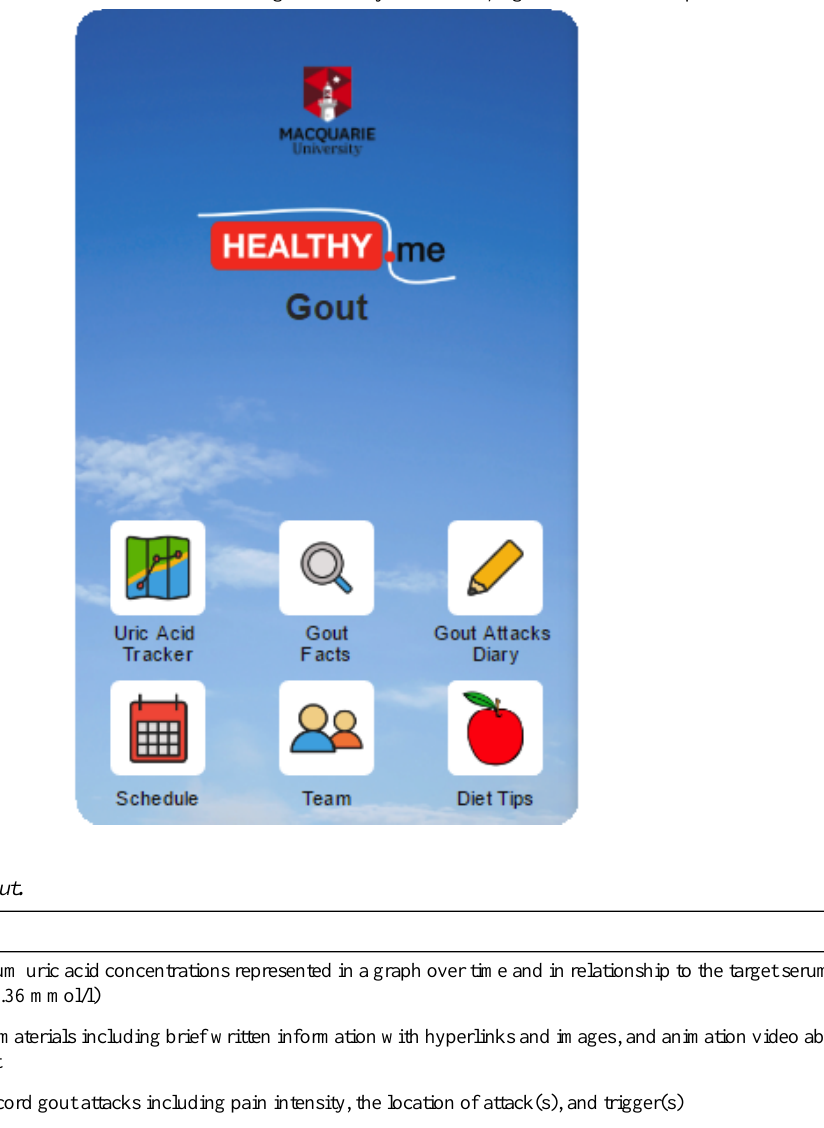
Figure 4. Screenshot of Healthy.me Gout home screen. Source: Image created by the authors, together with “The Explainers”.